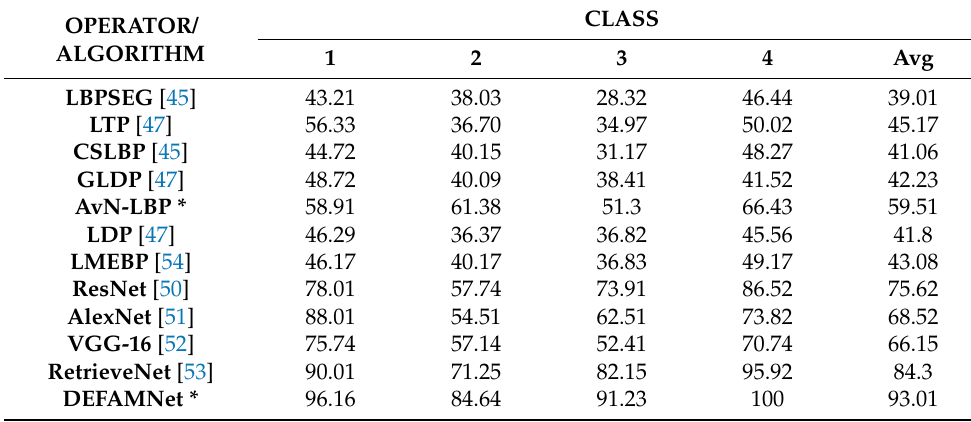
Table 4. Comparison of Retrieval Accuracy (ARP) on the OASIS database.